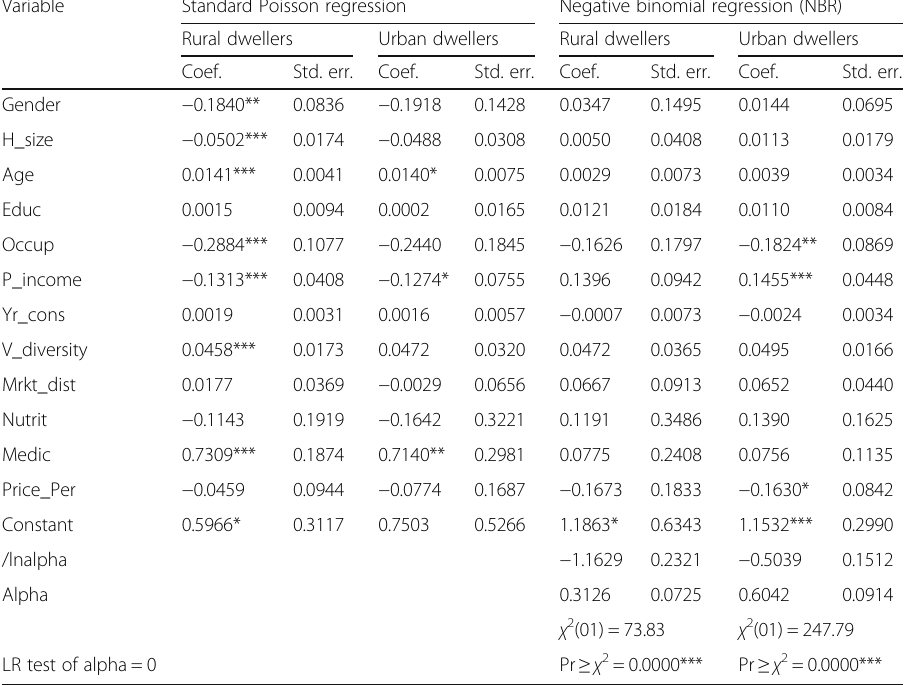
Table 4 Standard Poisson regression and NBR results on determinants of consumption intensity